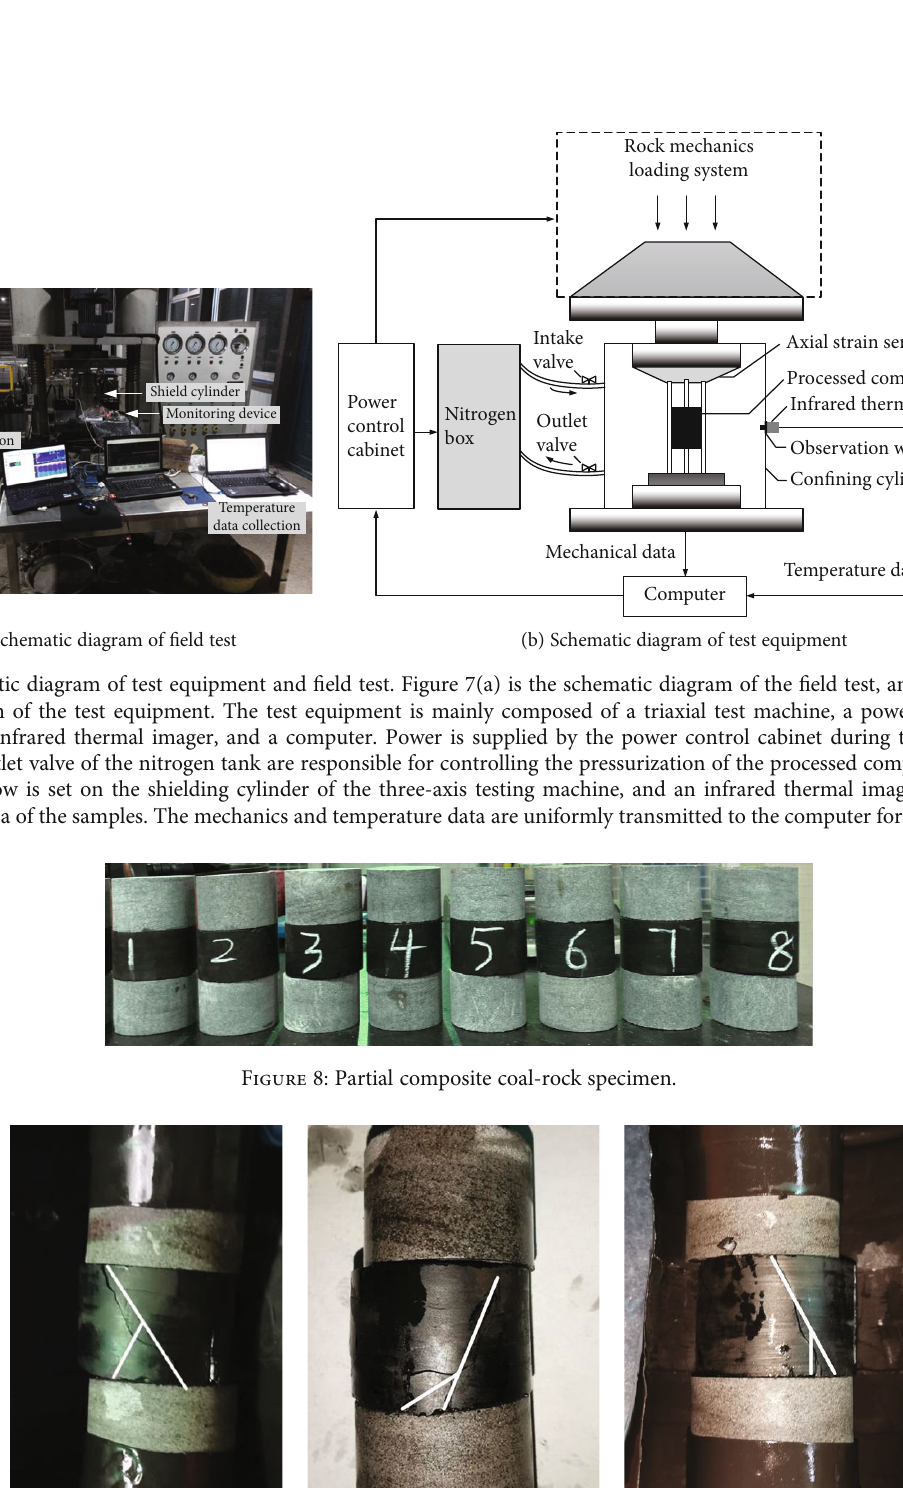
Figure 9: Experimental results of samples 1 # , 6 # , and 11 # . Among them, (a) is the T unloading con fi ning pressure rate is 0.003MPa/s; (b) is the T ave - σ - t experimental curve of sample 6 # when the unloading con fi ning pressure rate is 0.03MPa/s; (c) is the T ave - σ - t experimental curve of sample 11 # when the unloading con fi ning pressure rate is